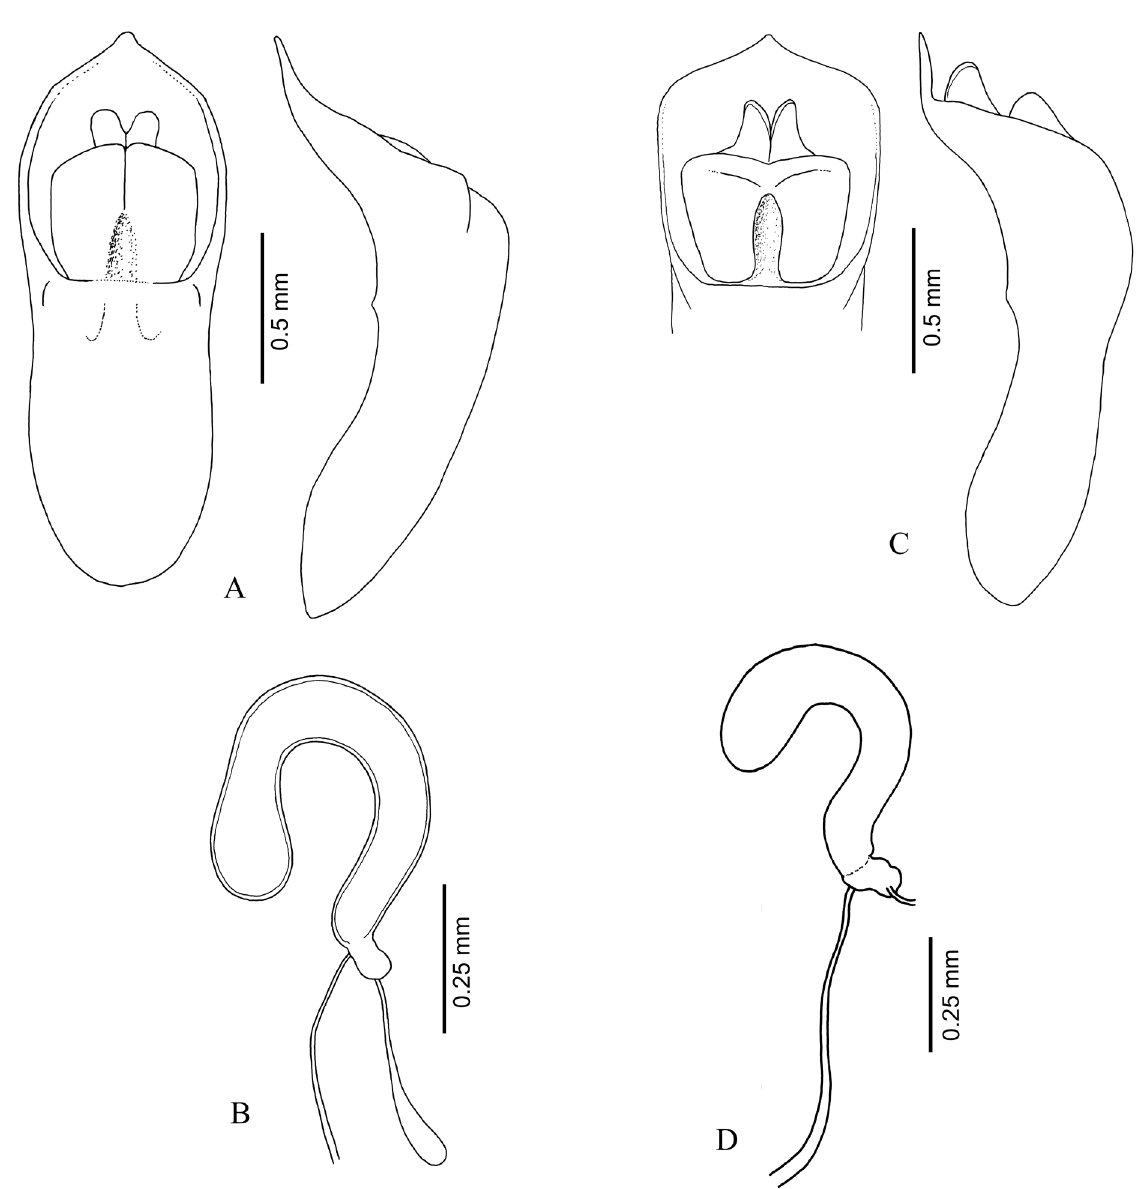
Fig. 10. A – B . Tituboea radeki Bezděk sp. nov. A . Aedeagus in dorsal and lateral views. B . Spermatheca. C – D . T. arabica (Olivier, 1808). C . Aedeagus in dorsal and lateral views. D .